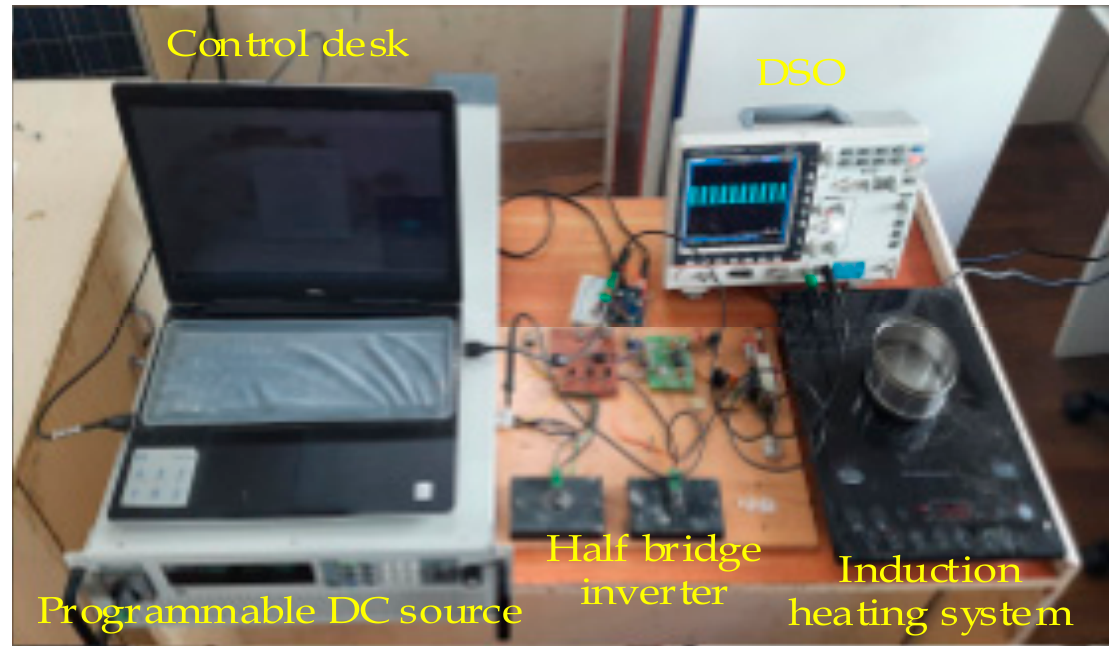
Figure 9. Experimental setup of the multi ‐ tapped induction heating system.